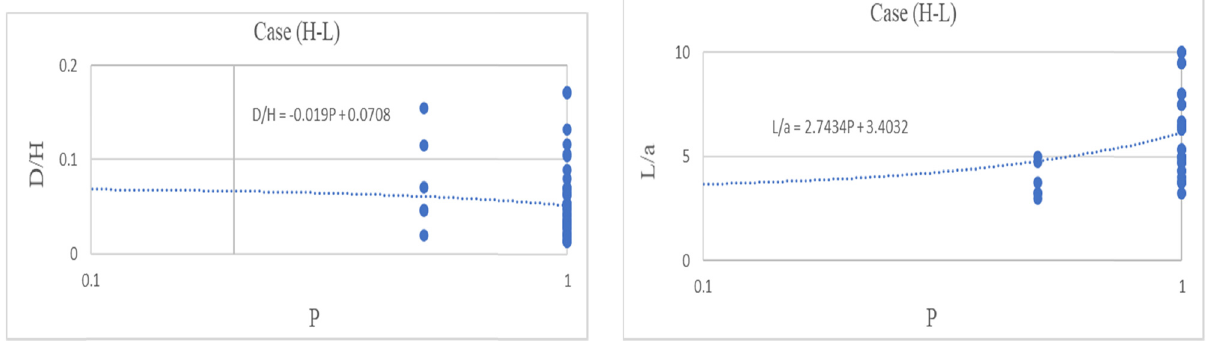
Figure 14: The relation of rootstocks length to sluice gate opening ( L / a ) to a trap index ( p ) for cases ( H – L ) .